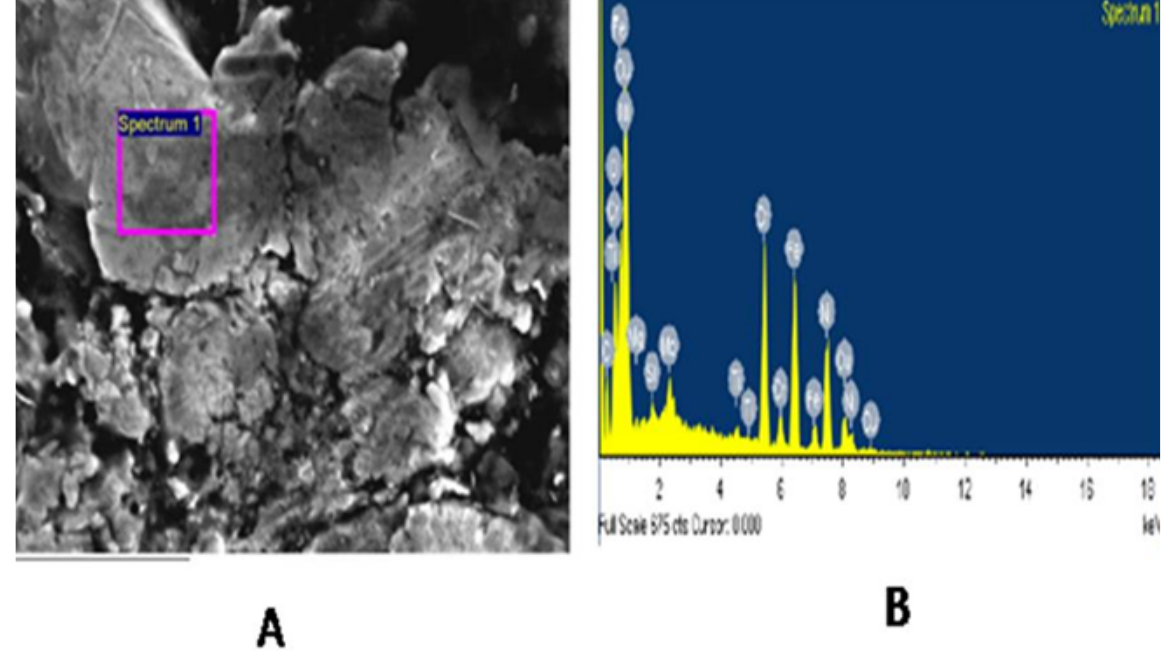
Figure 12: EDX analysis of work material